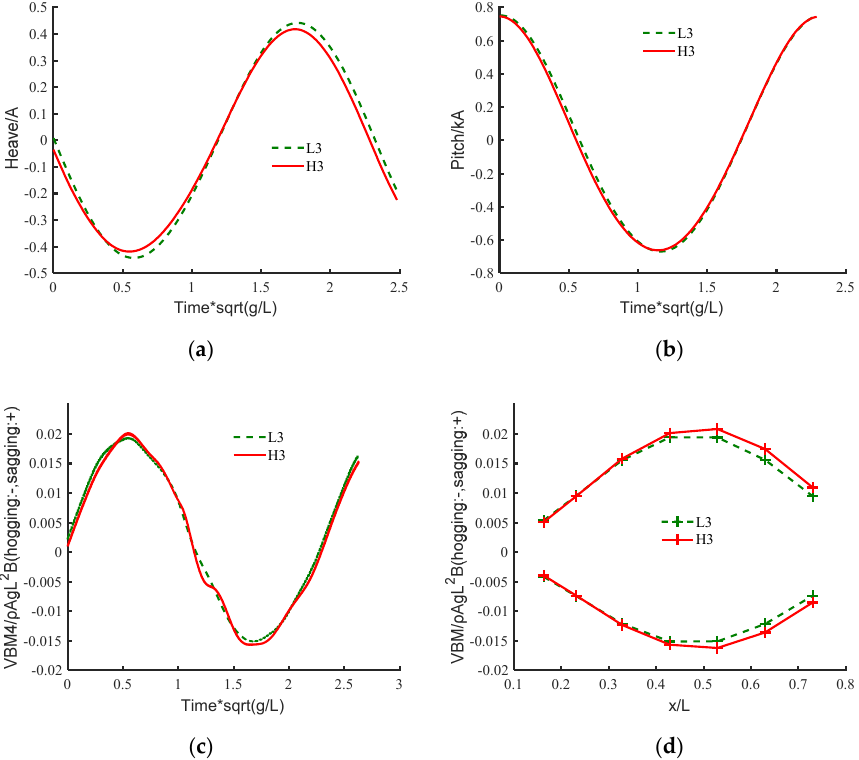
Figure 16. Comparison of structural response between L3 and H3. ( a ) time series of Heave; ( b ) time series of Pitch; ( c ) time series of VBM4; ( d ) VBM at seven sections.